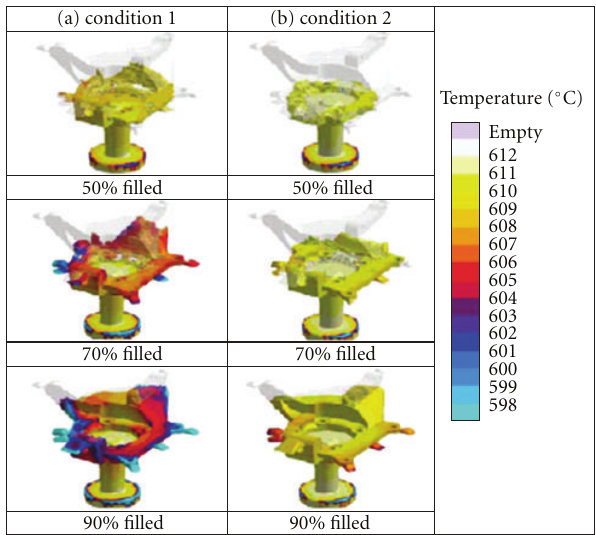
Figure 19: The comparison of filling behavior at conditions 1 and 2.